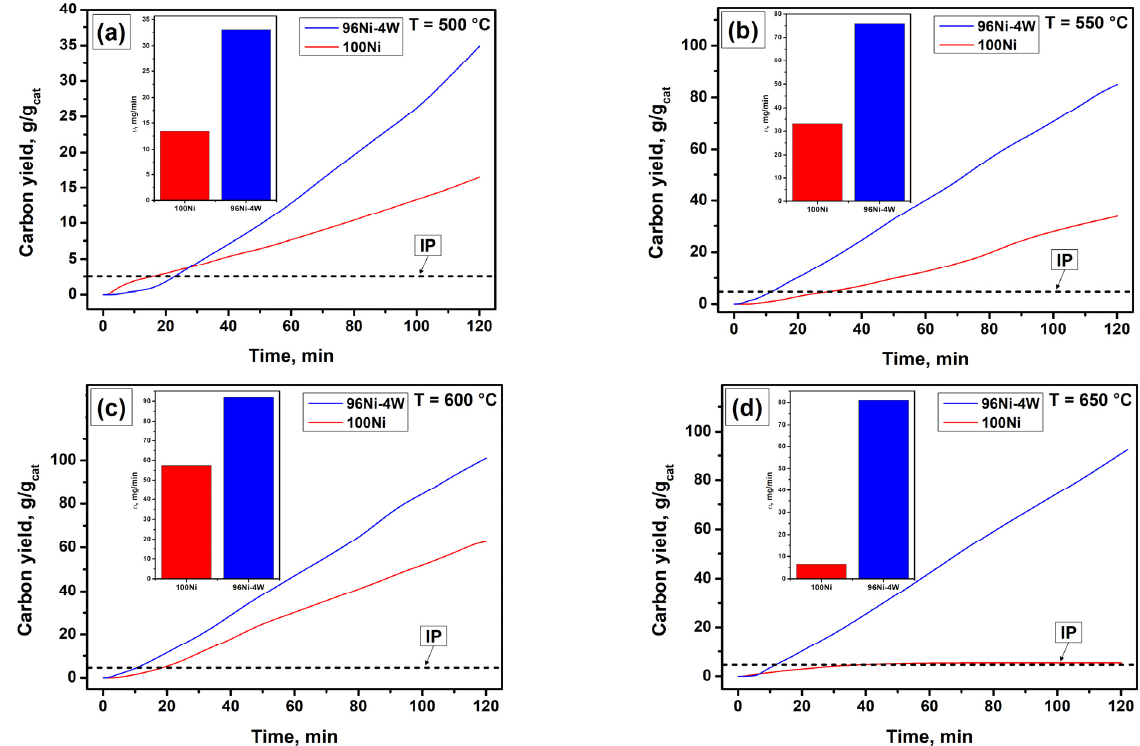
Figure 3. Carbon yield and corresponding carbon deposition rate ( v , mg/min) during the 2-h de- composition of TCE vapors in excess of H 2 over 100Ni and 96Ni-4W catalysts at temperatures: ( a ) 500 °C; ( b ) 550 °C; ( c ) 600 °C; ( d ) 650 °C. ( a ) 500 ◦ C; ( b ) 550 ◦ C; ( c ) 600 ◦ C; ( d ) 650 ◦